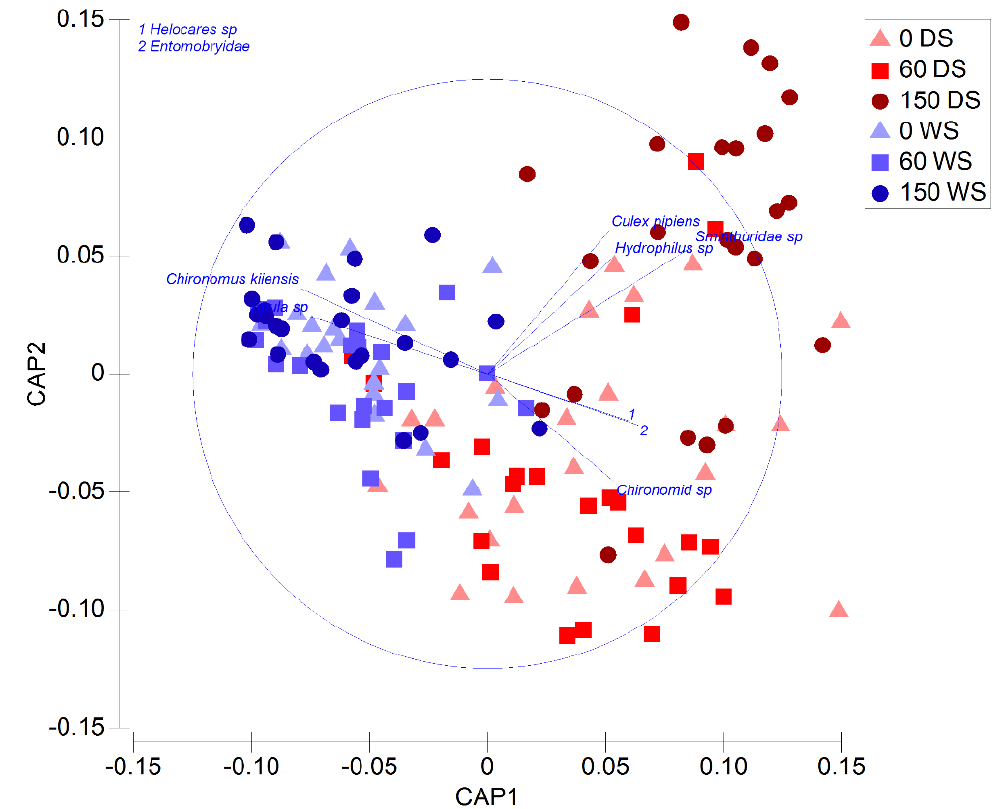
Figure 4. Canonical Analysis of Principal Coordinates (CAP) showing differences in decomposer species composition between blow-vac samples. Red colors indicate samples collected during the dry season (DS), whereas blue colors indicate samples collected during the wet season (WS). Nitrogen regimes (0 = 0 added N, 60 = 60 Kg N ha − 1 , and 150 = 150 Kg N ha − 1 ) are represented by increasing color darkness. Overlayed vectors (in blue) represent the correlations (Pearson’s correlation coefficient > 0.3) between decomposer species and the CAP axes, where vector length and direction reflect the increasing values of correlation and parameter values, respectively.